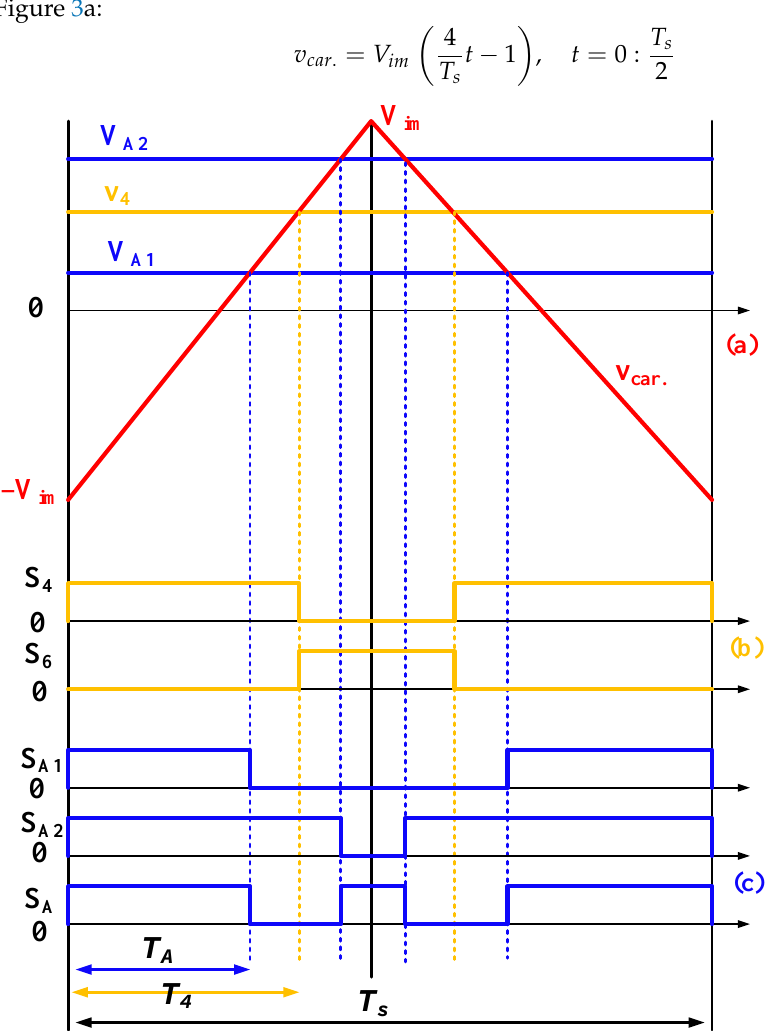
to create PWM signals. The carrier signal (( v car . ( t ) ) is defined as follows, as shown in